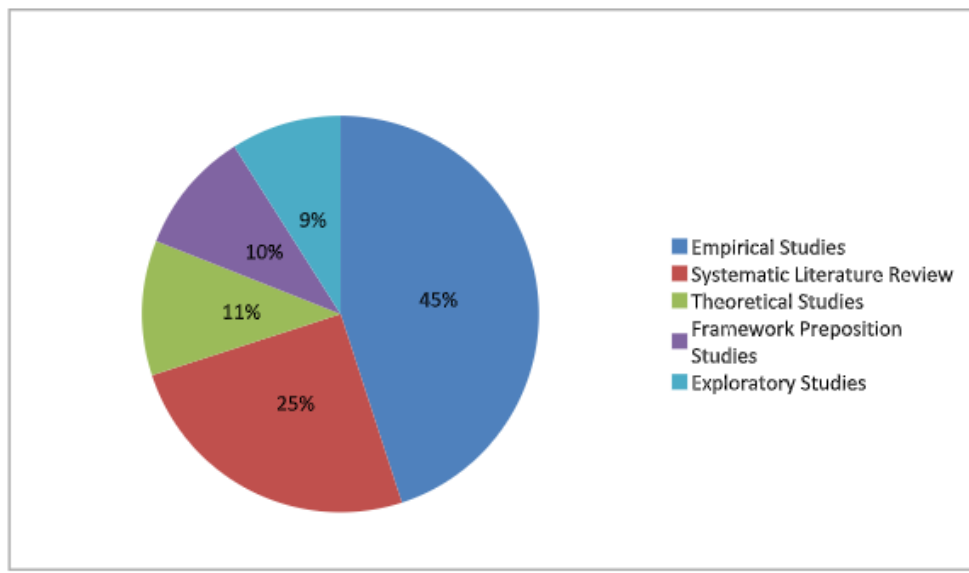
Figure 3. Percentage-wise distribution of the selected studies based on study